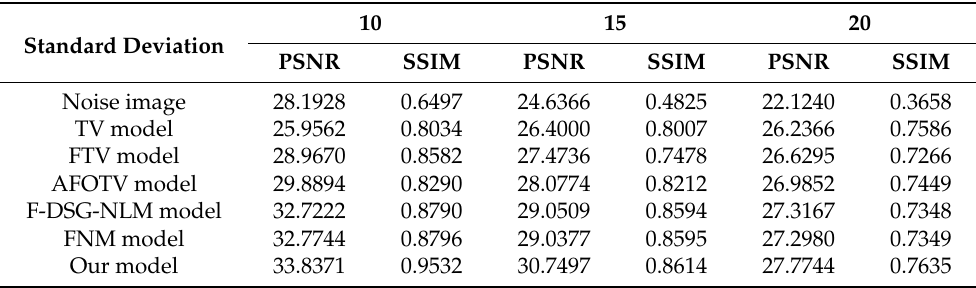
Table 3. Objective evaluation criteria of different models for the denoising effect of vitreous mecha- nization